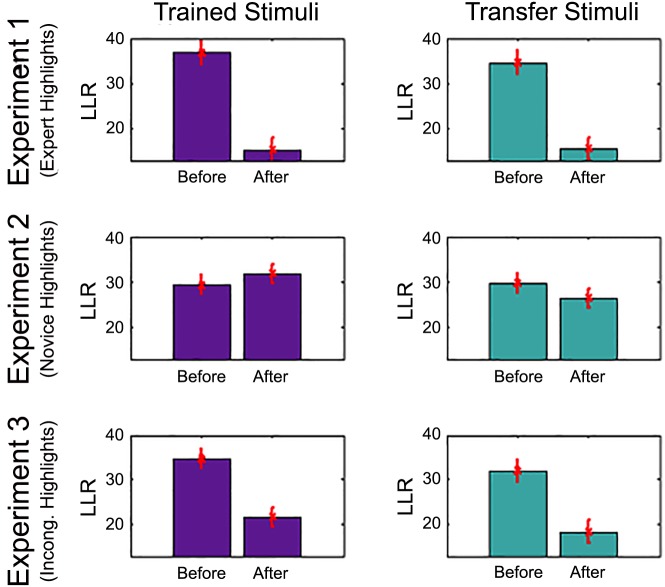
Summary of model-based analysis from Experiments 1–3.Each experiment is shown in a row of the figure, and the left column presents results for trained stimuli and the right column for transfer stimuli. The ordinate of each graph indicates the log likelihood ratio (LLR), a measure of relative expertise. An increase in the LLR from before to after training indicates acquisition of expertise. Experiment 1–3 involved highlighted training based on expert fixations, novice fixations, and incongruent expert fixations, respectively. The error bars are calculated to account for systematic tendencies of data derived from the same subject and variability between subjects [43].